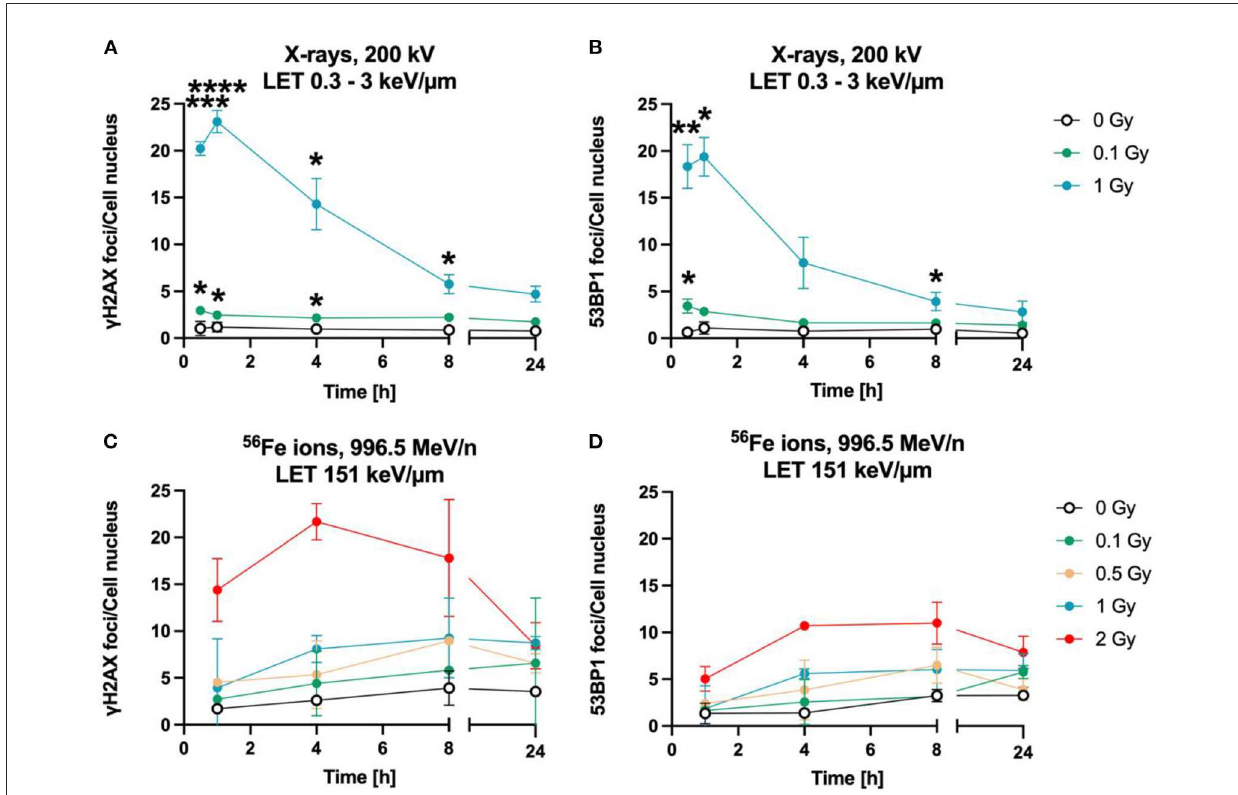
FIGURE3 Astrocytes encounter DNA double strand breaks after exposure to X-rays and iron ions and are fully repair-proficient via non-homologous end-joining. Astrocytes were mock-irradiated (0Gy) or irradiated with X-rays (200 kV, 15mA) with doses up to 1Gy (upper panel) or Fe ions (LET 151 keV/ µ m, 996.5 MeV/n) with doses up to 2Gy (lower panel). They were fixed at different time points up to 24h after irradiation for immunofluorescence staining of the DNA double strand marker γ H2AX (left) and the DNA repair protein 53BP1 (right). (A) Number of γ H2AX foci per cell nucleus after X-irradiation. (B) NHEJ activity was quantified over 24h by the number of 53BP1 foci in astrocytes’ nuclei exposed to different doses of X-rays. (A, B) The samples were compared via 2way ANOVA (Tukey’s multiple comparisons test), based on a sample size n = 3. Significant differences in comparison to 0Gy control are indicated by asterisks (* p < 0.05, ** p < 0.01, *** p < 0.0001, **** p = 0.0001). Cells showed a dose- and time dependent accumulation of 53BP1 foci. (C) Number of γ H2AX foci per astrocyte nucleus irradiated with different doses of 56 Fe ions ( n = 2). (D) Number of 53BP1 foci per cell after irradiation of astrocytes with different doses of 56 Fe ions ( n = 2). Data are shown as mean ± SD. In case that the error bars are smaller than the symbol, they are not visible (B, D)